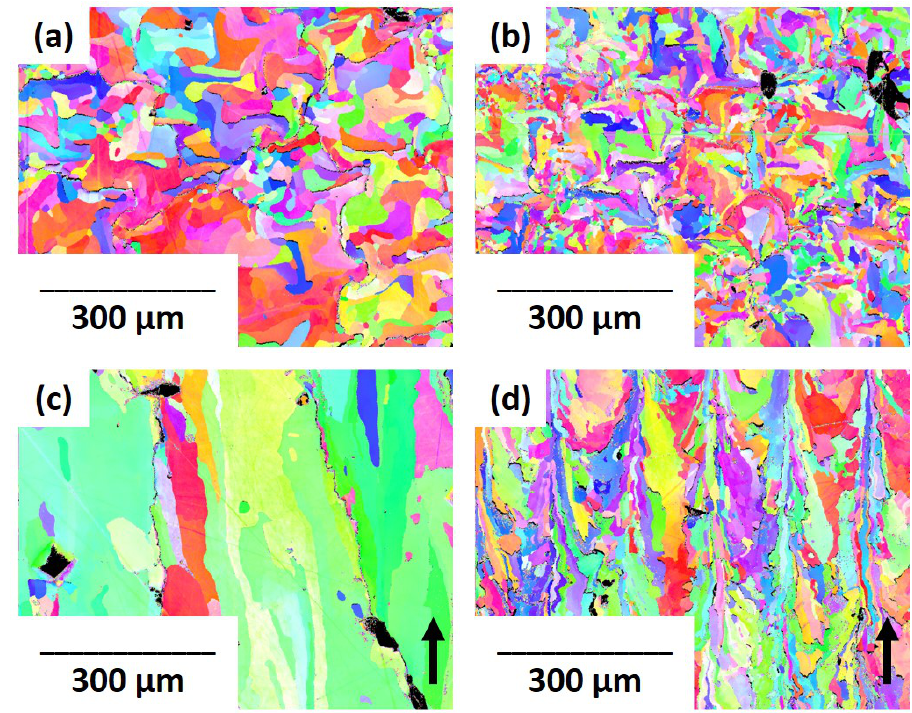
Figure 4. EBSD map of Mo-0.1SiC: ( a ) Top surface of 100 mm/s specimen. ( b ) Top surface of 400 mm/s specimen; ( c ) Side surface of 100 mm/s specimen; ( d ) Side surface of 400 mm/s specimen.